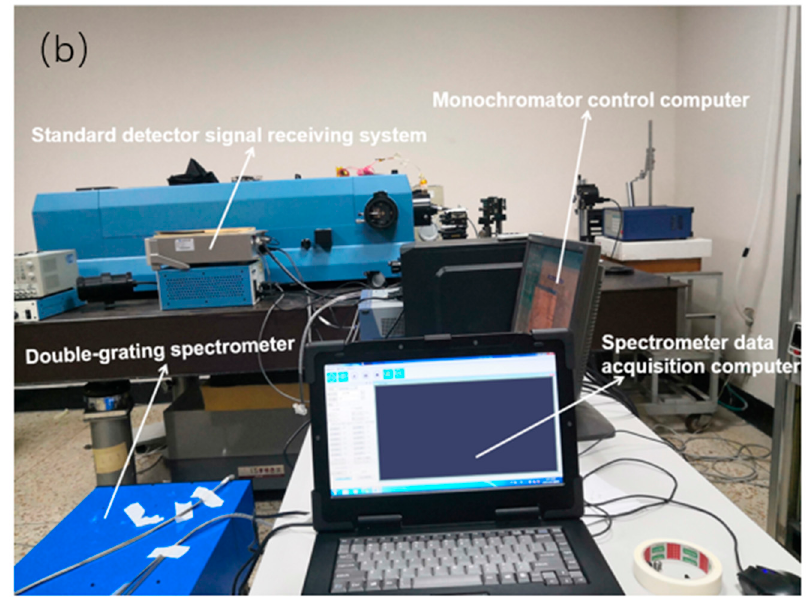
Figure 16. Water vapor absorption band (758–880 nm) spectrum calibration system: ( a ) Water vapor absorption band (758–880 nm) spectrum calibration flow chart; ( b ) The instrument of the water vapor absorption band (758–880 nm) spectrum calibration system and the working principle.